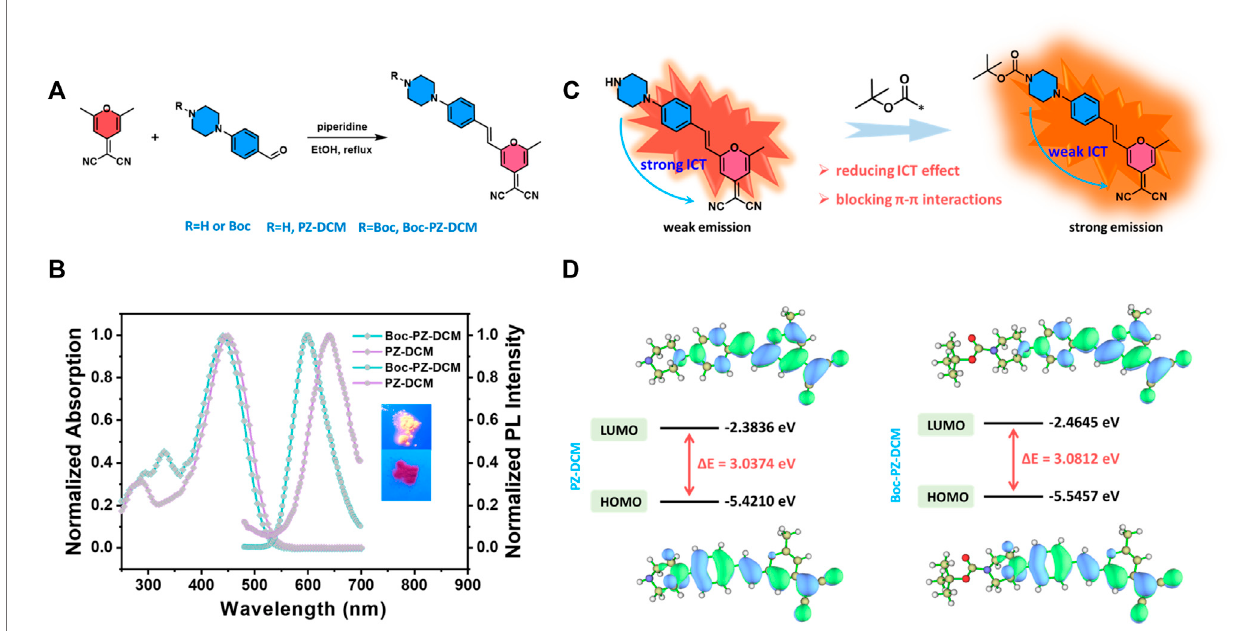
FIGURE 1 | (A) The synthetic route of compounds PZ-DCM and Boc-PZ-DCM. (B) Normalized absorption and fl uorescence spectra of PZ-DCM and Boc-PZ- DCM.TheabsorptionspectraweremeasuredinTHFsolutionwiththedyeconcentrationof10 μ M.The fl uorescencespectraweremeasuredinsolidstateunder410 nm excitation. Inset: Fluorescent photographs ofPZ-DCM (bottom) and Boc-PZ-DCM (top) under 365 nm irradiation. (C) Schematic diagram for fl uorescence properties of PZ-DCM and Boc-PZ-DCMS affect by ICT effect. (D) HOMO and LUMO energy levels of PZ-DCM and Boc-PZ-DCM. Molecular orbital amplitude plots of HOMO and LUMO energy levels calculated using the B3LYP/6-31G(d) basis set in the Gaussian 09 program. Δ E (energy gap) = LUMO – HOMO.